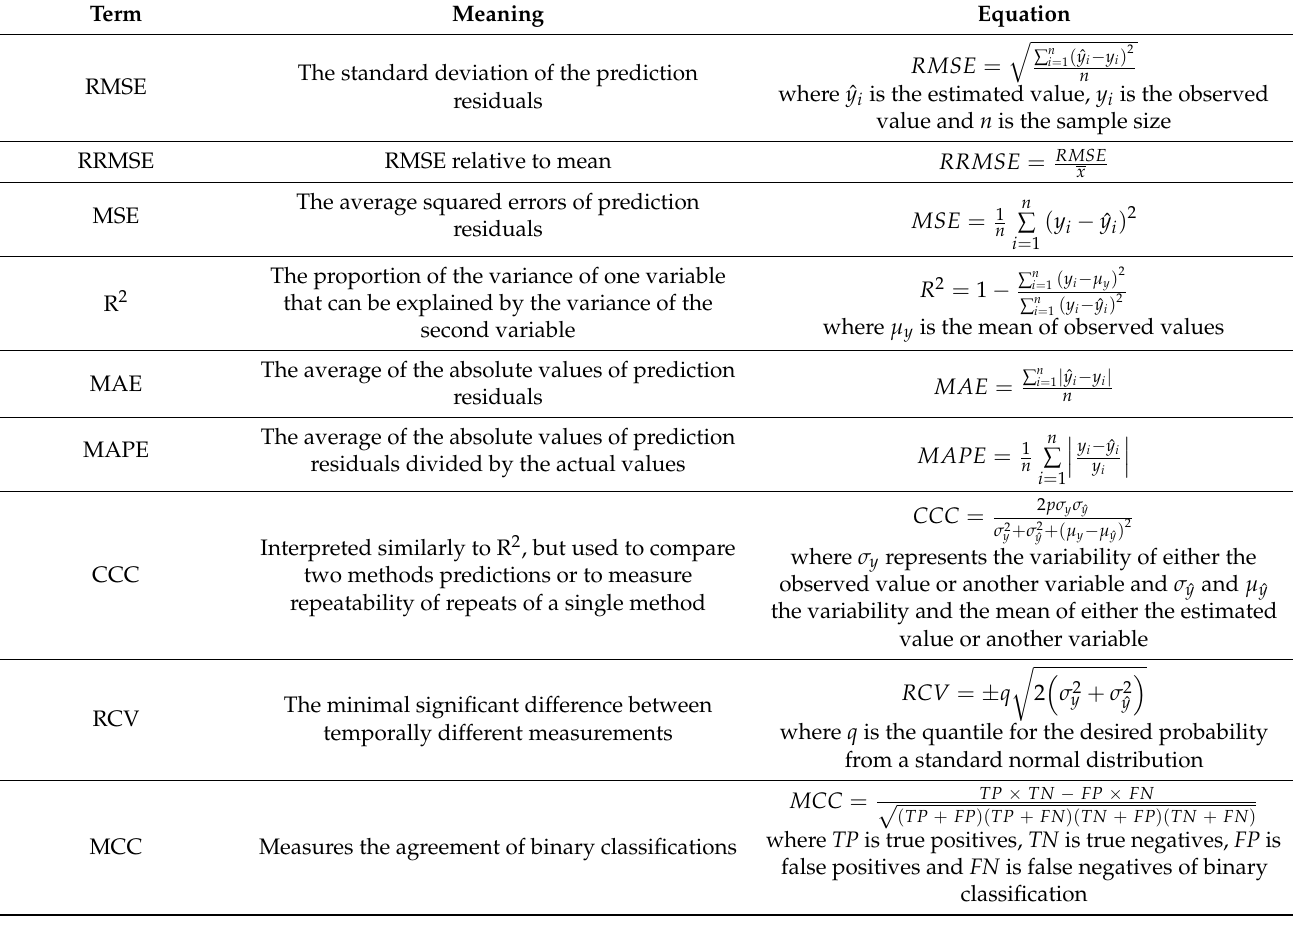
Table 2. Definition of evaluation